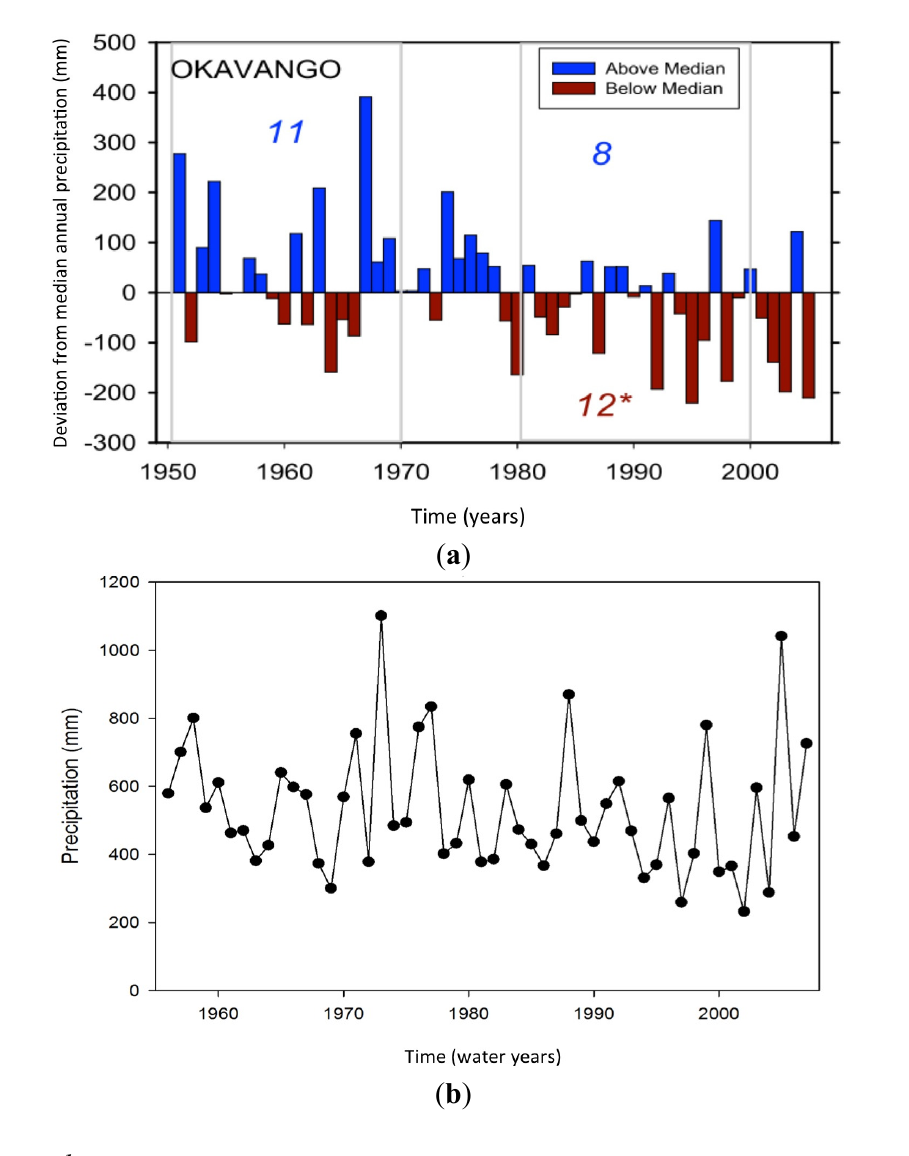
Figure 4. Annual precipitation for ( a ) Deviations from the 1951–2005 median annual precipitation for the Okavango drainage basin overall, and ( b ) Shakawe station precipitation data from 1951 to